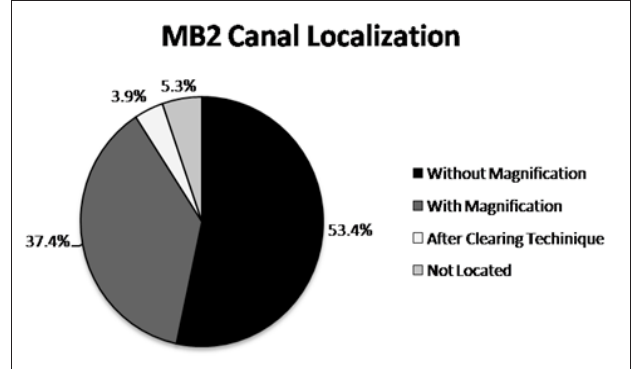
Fig. 1. MB2 location in teeth in different